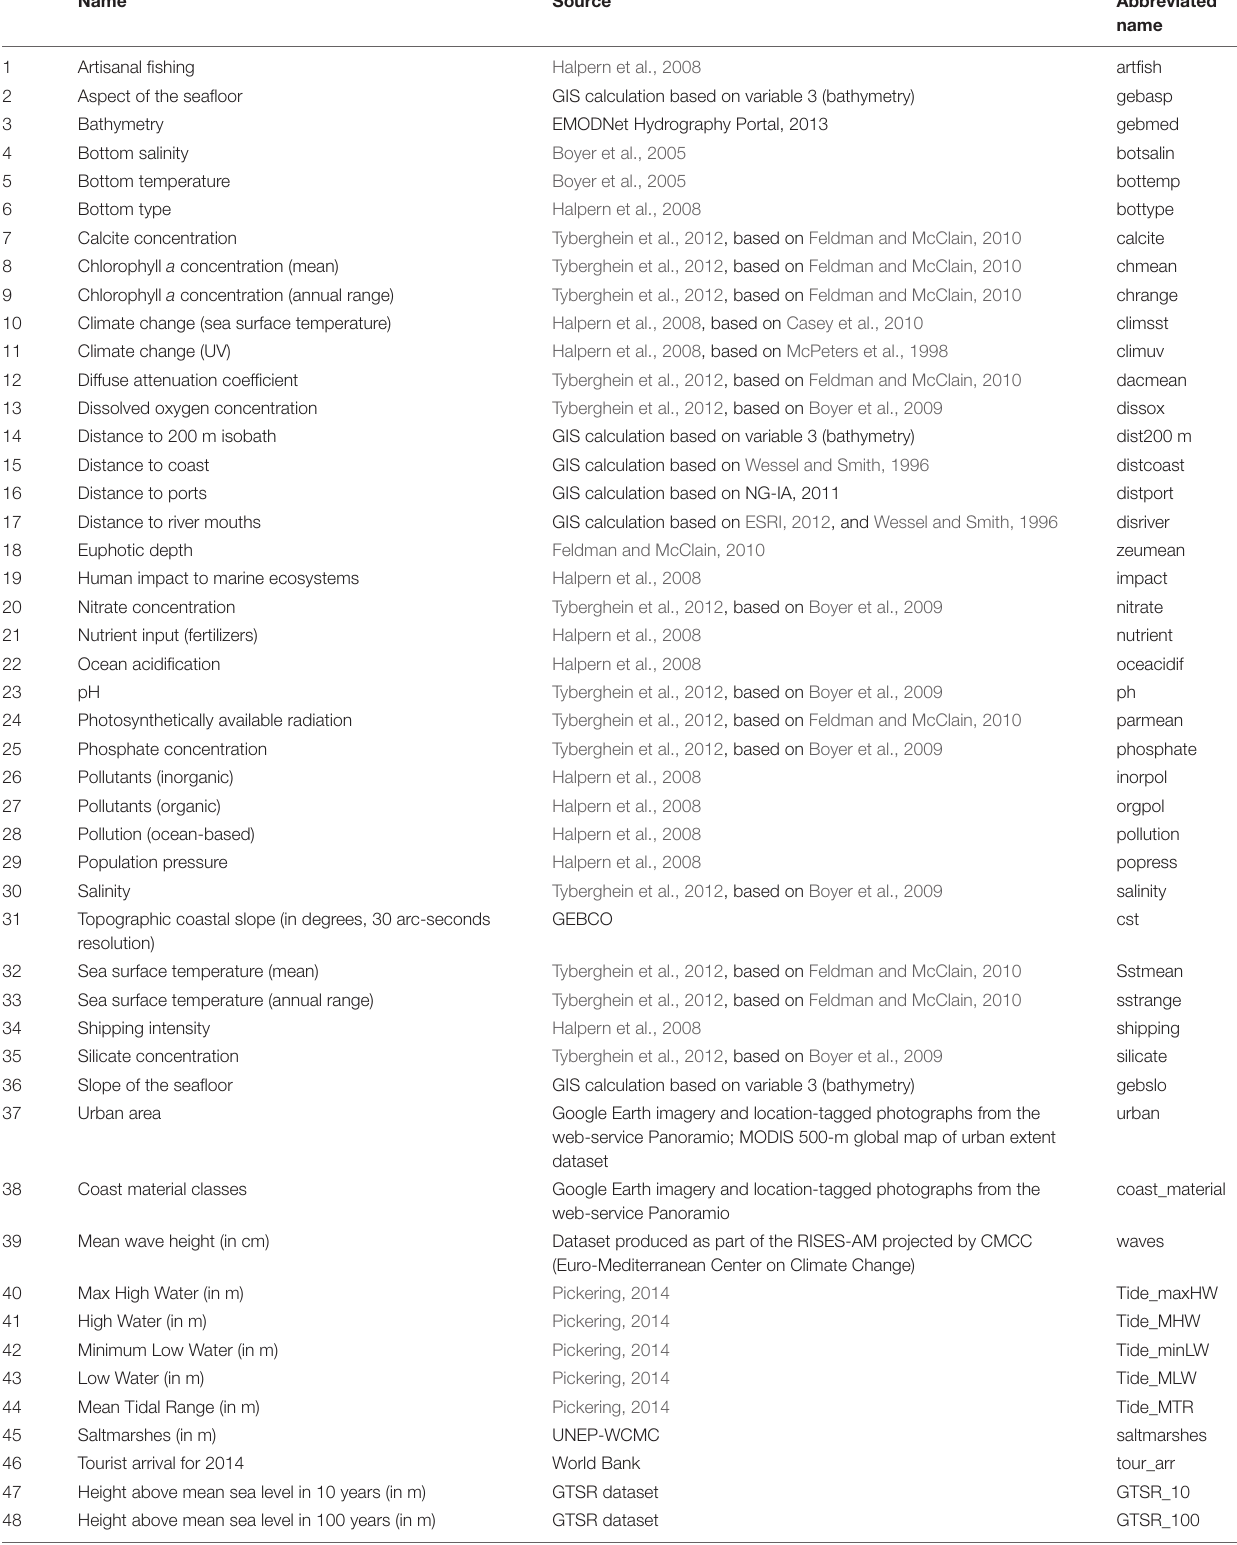
TABLE 1 | Predictor variables used for the HSM with their units, source and the abbreviated